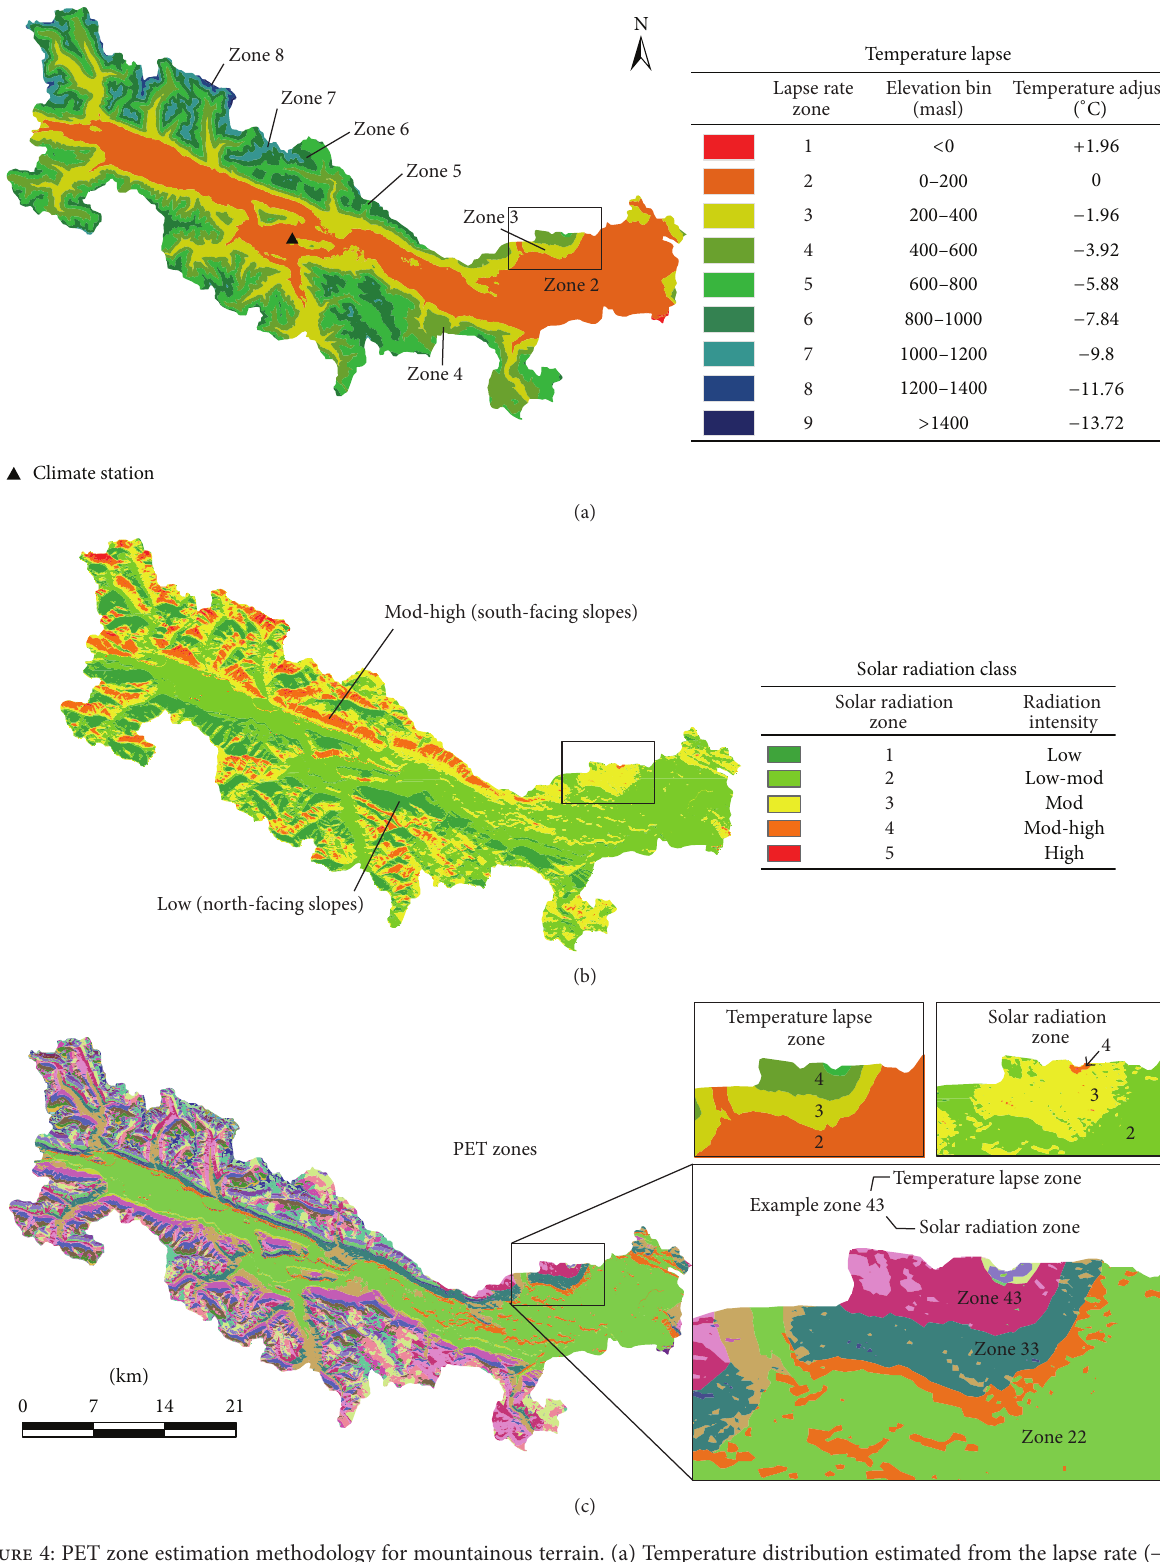
Figure 4: PET zone estimation methodology for mountainous terrain. (a) Temperature distribution estimated from the lapse rate ( − 9.8 ∘ C per 1000 m increase in elevation); (b) solar radiation classes (range of zones: Zone 1—consisting of steep north-facing slopes with reduced radiation from mountain shadow, to Zone 5—high altitude, south facing slopes not impeded by mountain shadows); (c) merged PET zones (42 PET permutations across the